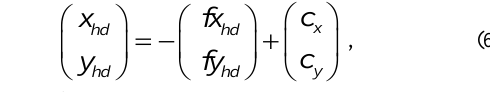
Where f is the focal length and c x , c y are the pixel coordinated of the principal point. (Luhmann, 2014) Radial Distortion R1: -0.040 Radial Distortion R2: -0.012 Radial Distortion R3: 0.007 Table 3. Radial and tangential distortion of the camera lens